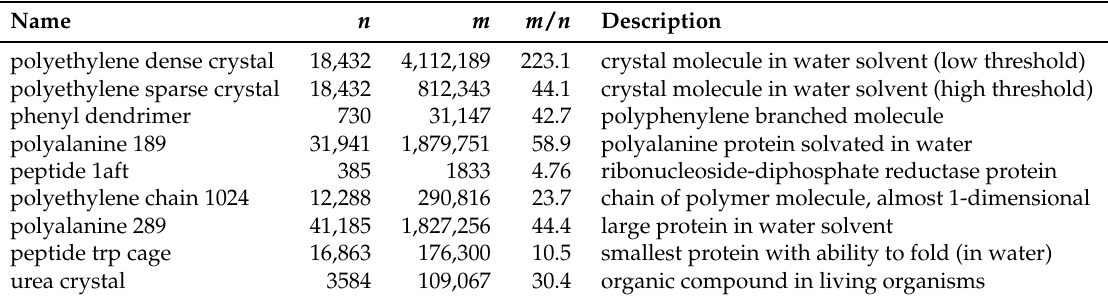
Table 1. Physical systems of our study: Number of vertices n in the graph and number of edges m . Table taken from [12]. Copyright c (cid:13) 2016 Society for Industrial and Applied Mathematics. Reprinted with permission. All rights reserved.